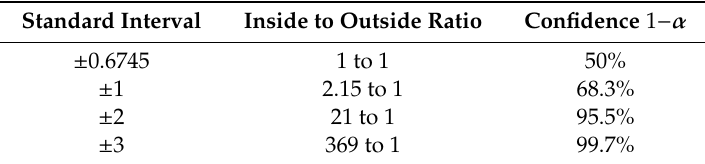
Table 5. Common Confidence Intervals for a Gaussian variable